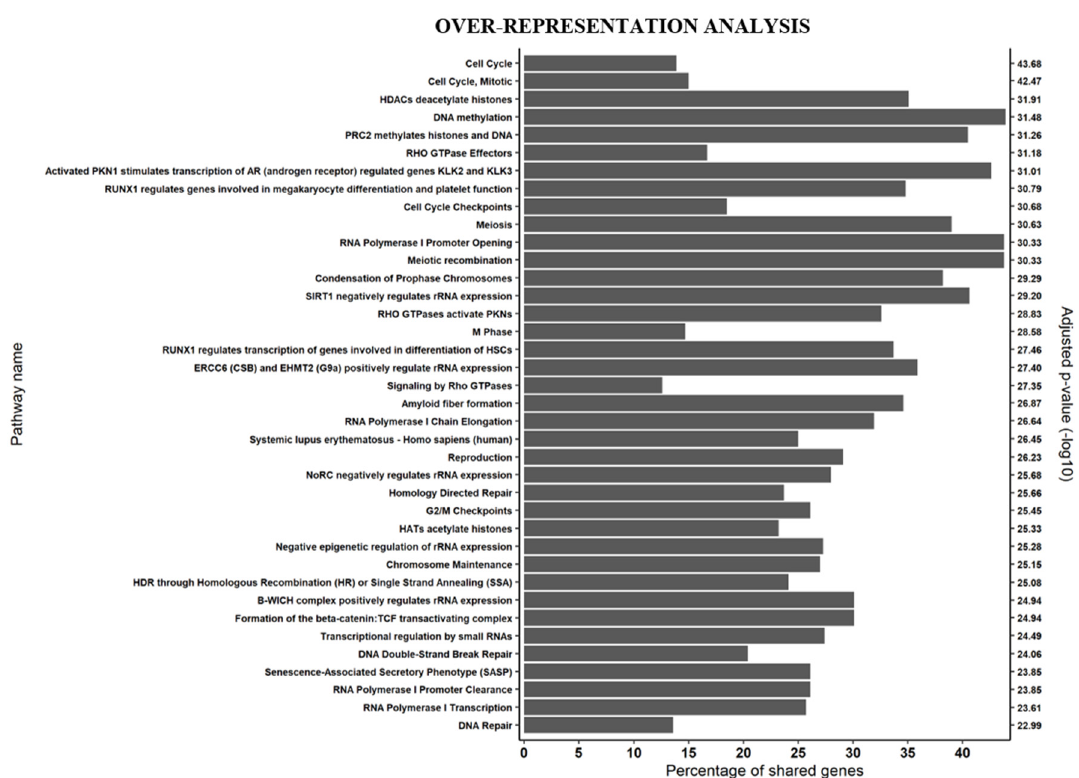
Figure 1. RNA-seq analysis on AZA pre-treatment MDS/AML-MRC CD34 + hematopoietic stem/progenitor cells isolated from 10 AZA-responders (RD) and nine patients with disease progression (PD). Identification of overrepresented biological processes in the differentially expressed genes (DEGs) between RD and PD (FDR < 0.05) compared to listed biological pathways using ConsensusPathDB with minimum overlap of 15 genes in pathway and p -value cut-off of 0.01. The percentage of DEGs associated with each biological process is shown along the x -axis and − log10-transformed p -values on the y -axis. To show the most significant results of over-representation analysis, a subset of full plot was constructed in which only pathways with a log transformed p -value of 23 and greater were kept. For the full plot see Figure